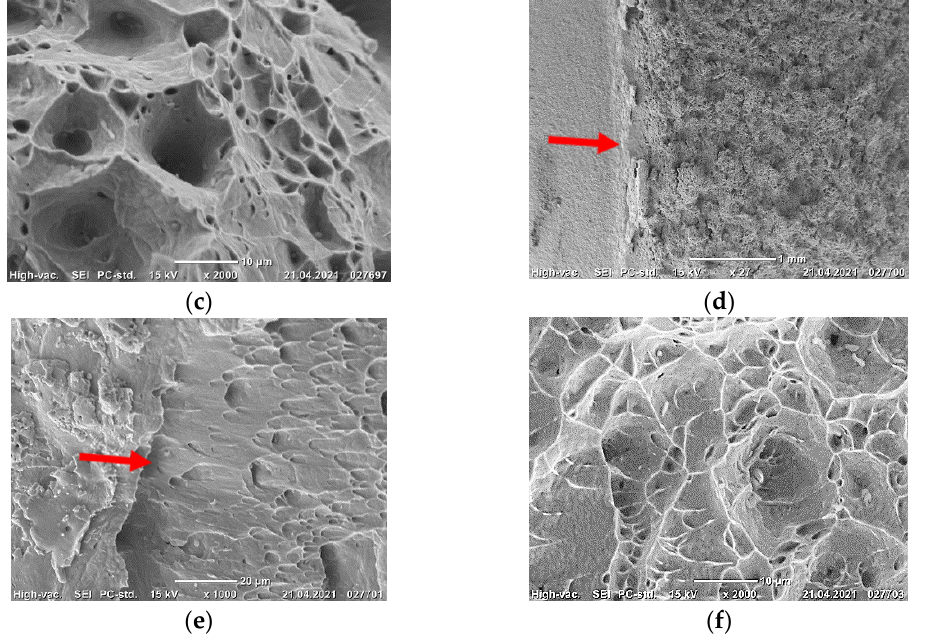
Figure 6. Microrelief of the impact fracture surfaces of the CG ( a – c ) and UFG ( d – f ) steel in the crack initiation nucleus ( a , b , d , e ) (nucleus marked by an arrow) and in the central part of the fractures ( c , f ). ( a , d )—×30; ( b , c , f )—×2000; ( e )—×1000.